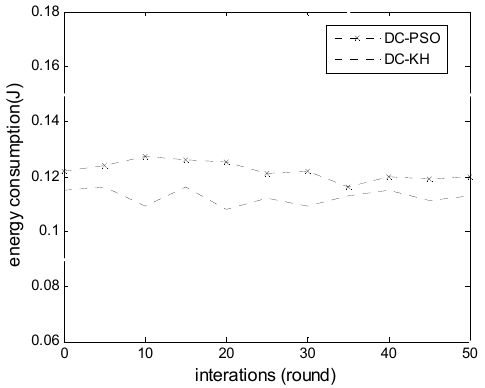
Figure 2. Energy consumption comparison chart of cluster head. Table 1. Simulation parameters.